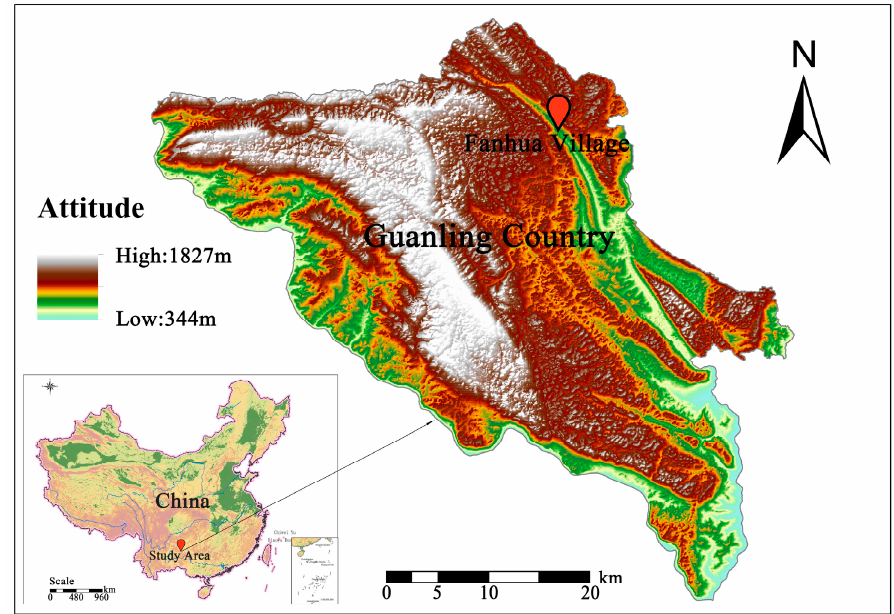
Figure 2. Regional location map of Fanhua Village.